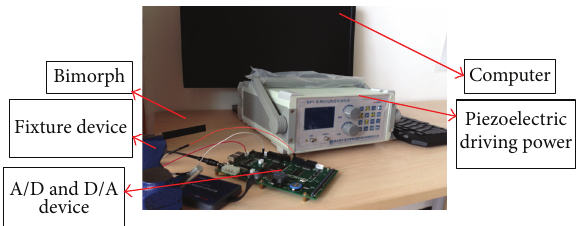
Figure 1: A vibration measure system for a piezoelectric